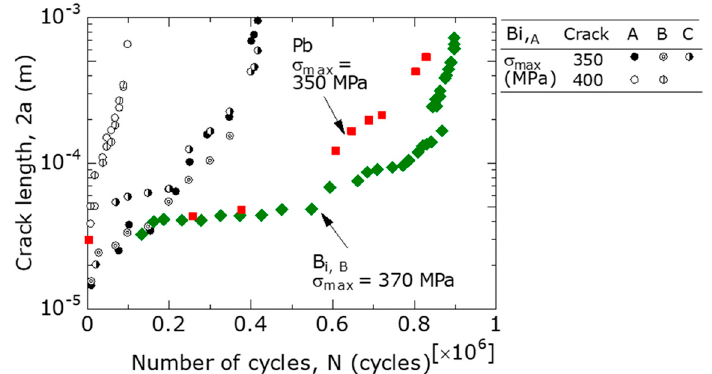
Figure 8. FCG curves at R = 0.1.